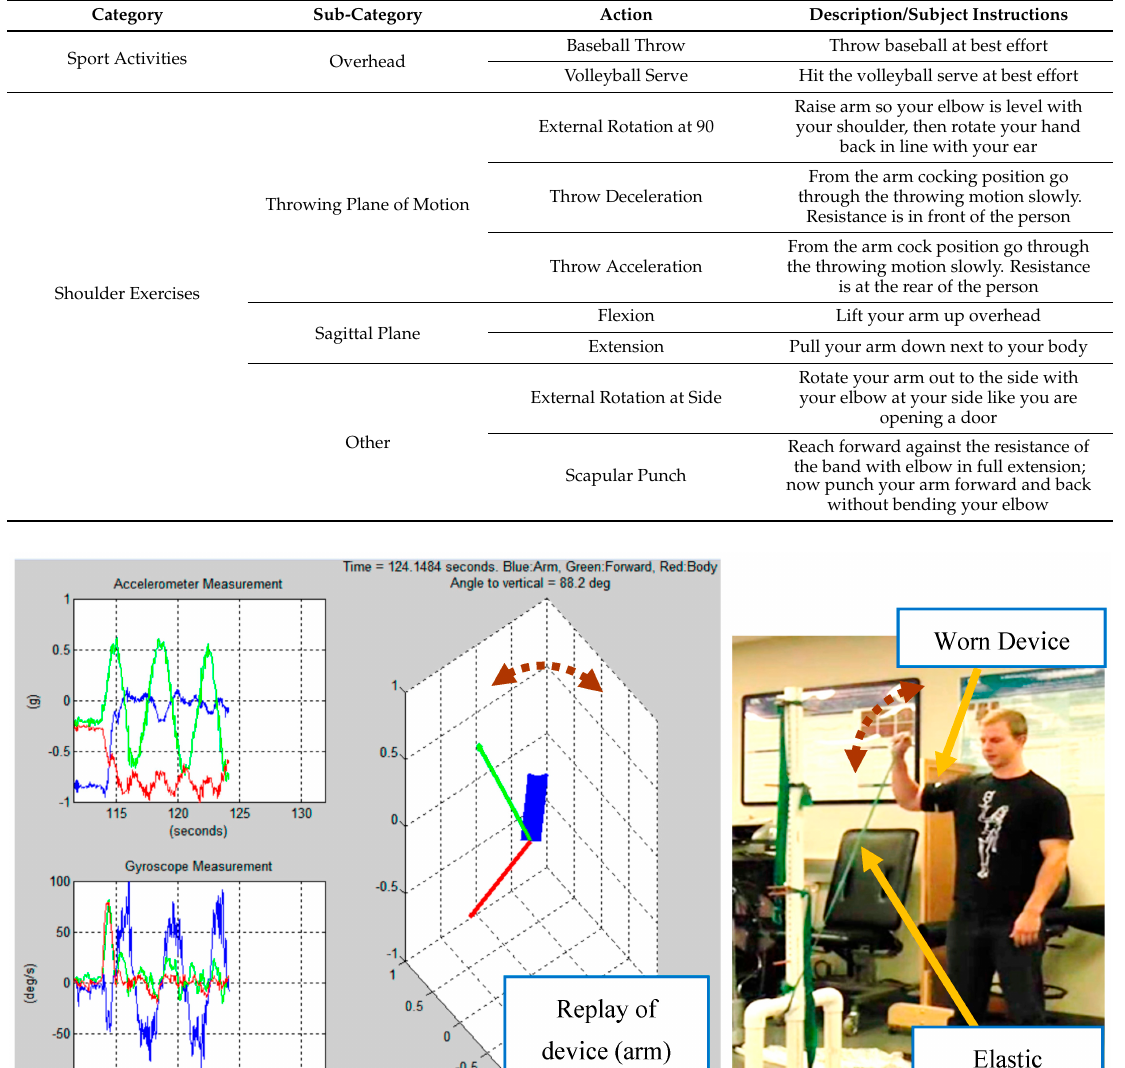
Table 1. Outline of performed activities under IRB #13-0602-F1V at the University of Kentucky.